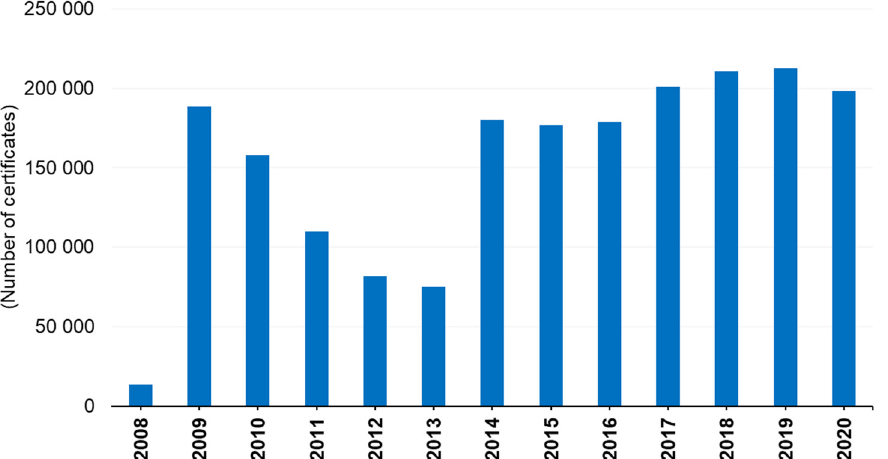
Figure 3. Energy performance certi fi cates issued in Portugal during 2008–2020. The authors created